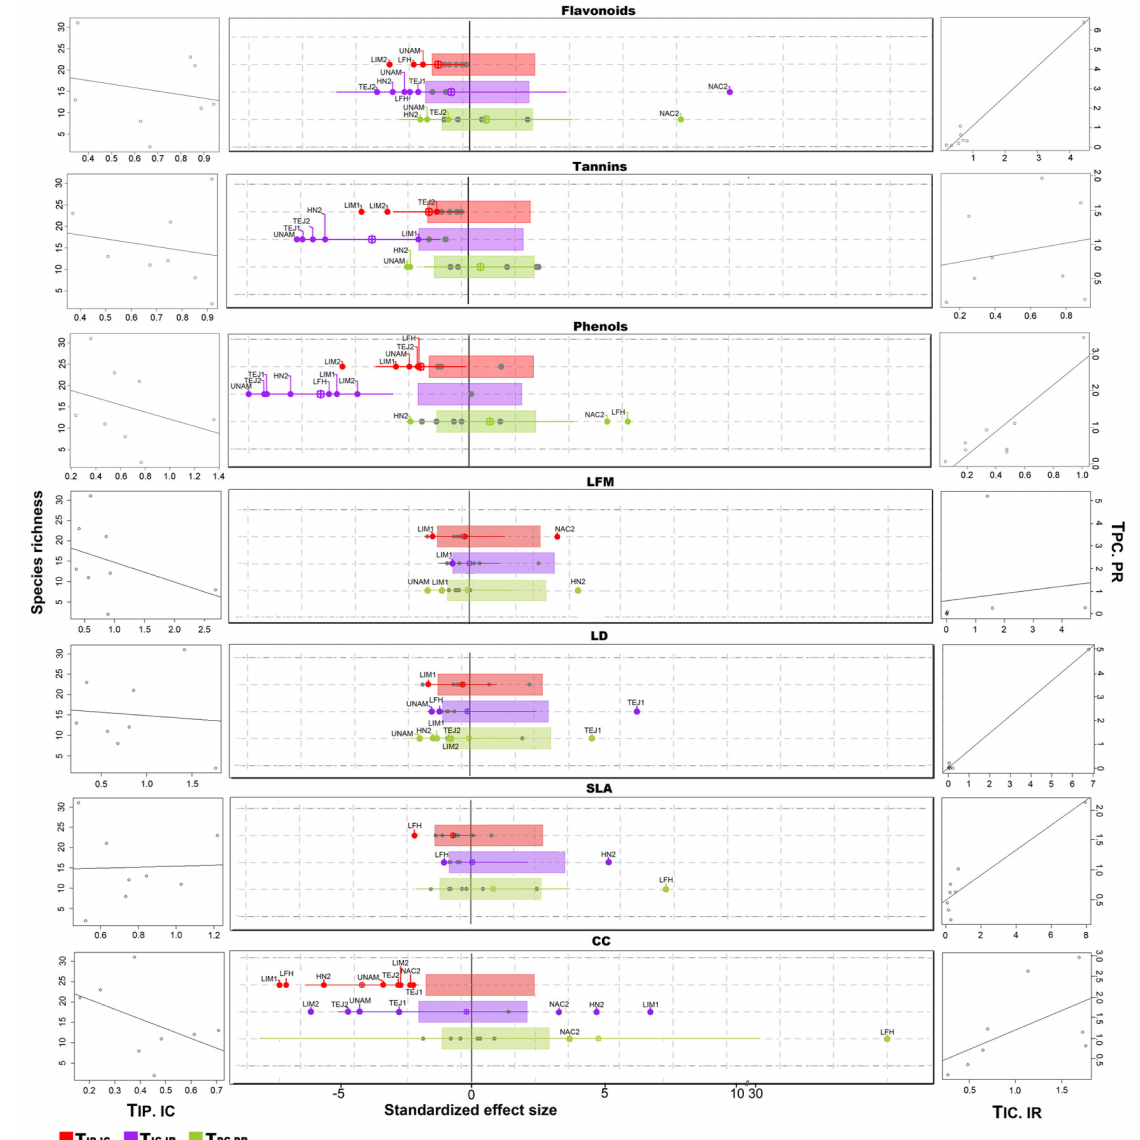
Figure 3. Standardized effect size (SES) of T-statistics corresponding to each tree community for the studied functional traits. Traits: total phenols concentration (Phenols); tannins concentration (Tannins); flavonoids concentration (Flavonoids); chlorophyll content (CC); specific leaf area (SLA); leaf density (LD); leaf fresh mass (LFM). T-statistics: within-population variance relative to the total variance in the community (TIP/IC); within-community variance relative to the total variance in the regional pool, assessed at the individual level (TIC/IR); and within-community variance relative to the total variance in the regional pool, assessed at the population level (TPC/PR). Dots represent the SES values for each plant community. Gray dots represent T-statistics that are not different from random expectations, whereas red, violet, and green dots represent T-statistics that do differ from random expectations (negative and positive SES indicate lower and higher values than random expectations, respectively). The crossed circles represent the SES value averaged across plant communities and the colored rectangles correspond to the average confidence intervals (0.025–0.975). Crossed circles that are not embedded within rectangles are different from random expectations. Graphs on the left show the relationship between plant community species richness and its corresponding TIP/IC, whereas graphs on the right side show the relationships between TIC/IR and